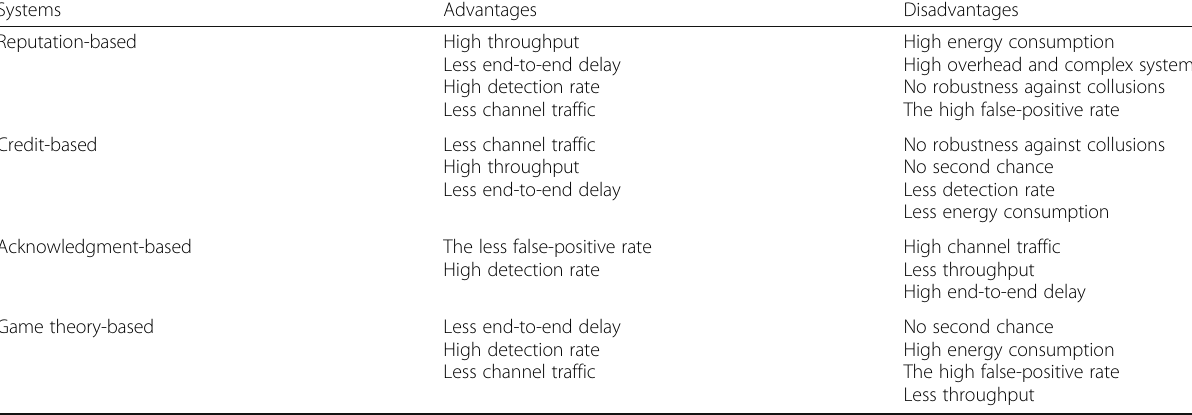
Table 1 Advantages and disadvantages of systems Systems